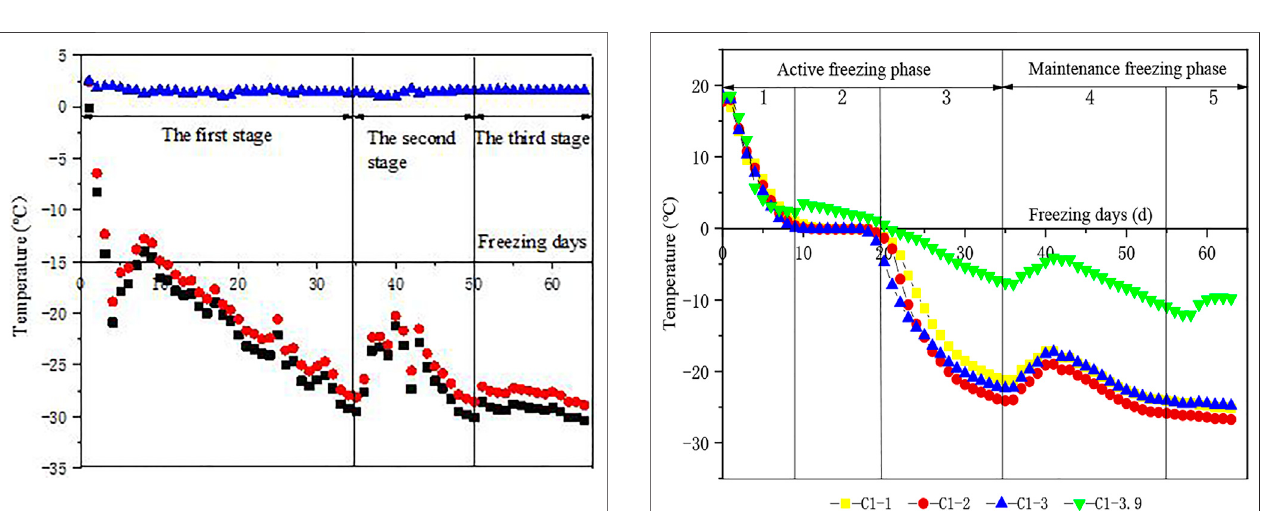
FIGURE 7 | Temperature curves of salty water in the freezing pipe and temperature difference between feeding and returning brines.